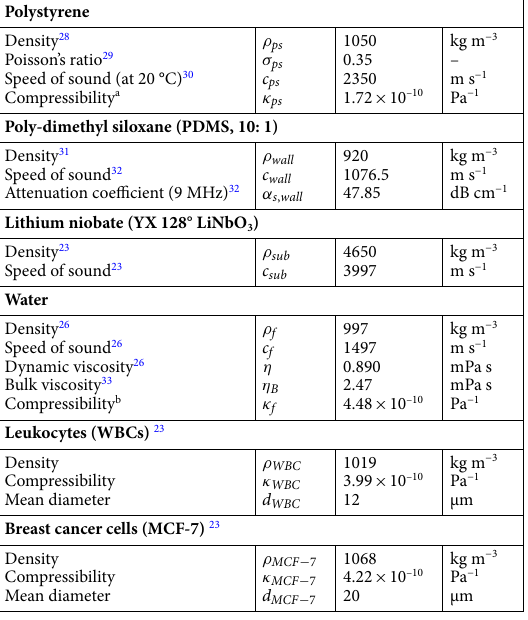
3 ( 1 − σ ps ) 1 34 . ( 1 + σ ps ) (ρ ps c 2 ps )